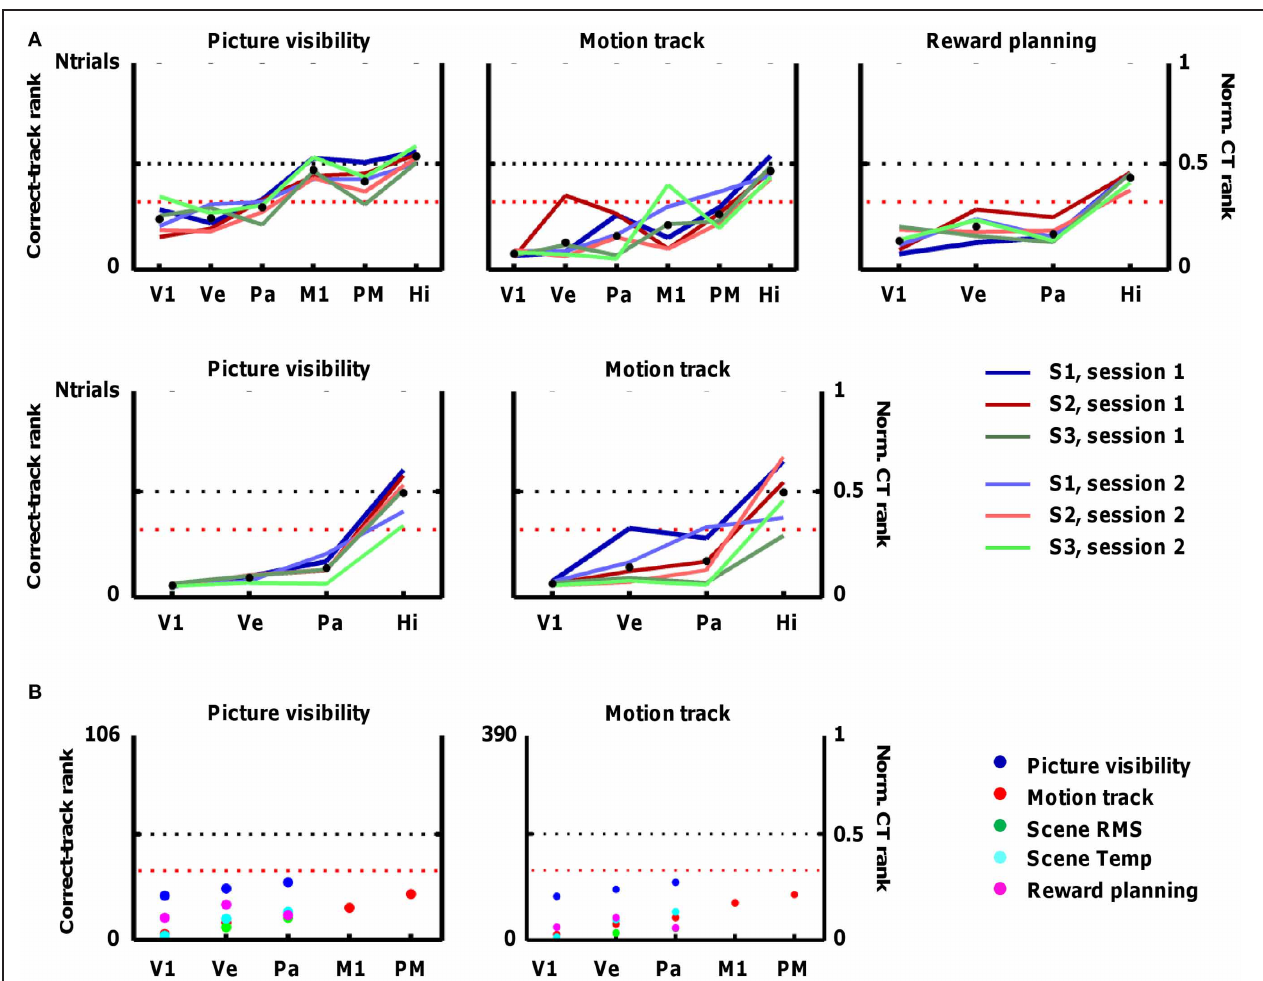
FIGURE 5 | Accuracy of fMRI decoding in predicting the track that subjects followed in each trial. The fMRI data are used to predict the occurrence of particular sources of information (e.g., picture visibility) at every time point, and the alternative tracks are ranked based on how much they resemble this prediction across all time points. Accuracy is represented by the correct-track rank (left Y -axis), which is the rank given to the correct track when all alternative tracks are ranked according to how much they deviate from the prediction. The right Y -axis shows the normalized correct-track (CT) rank, which is the correct-track rank divided by the number of alternative tracks plus 1. A normalized correct-track rank of 0.5 corresponds to chance performance (no decoding ability; black